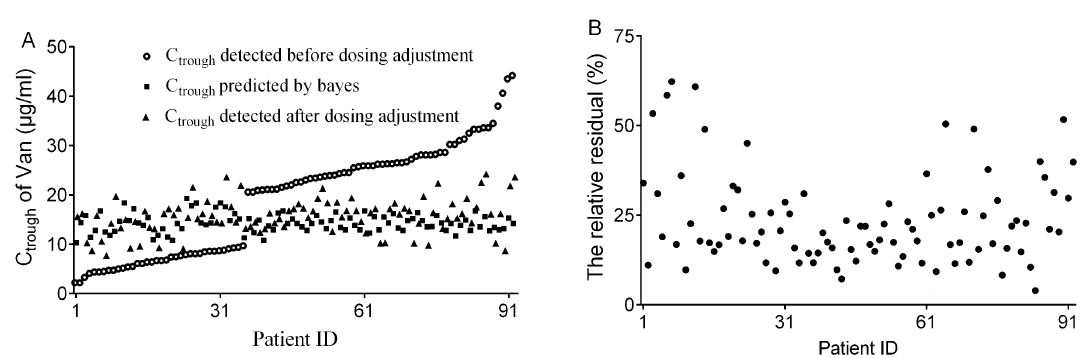
Figure 3. Results of dosing adjustment for 92 patients hospitalized in the ICU by Bayes feedback based on the final model. ( A ) The distribution diagram of routine C trough detected before dosing adjustment, C trough predicted by the Bayes method and C trough detected after dosing adjustment. ( B ) The relative predicted residuals of C trough predicted by the Bayes method versus C trough detected after dosing